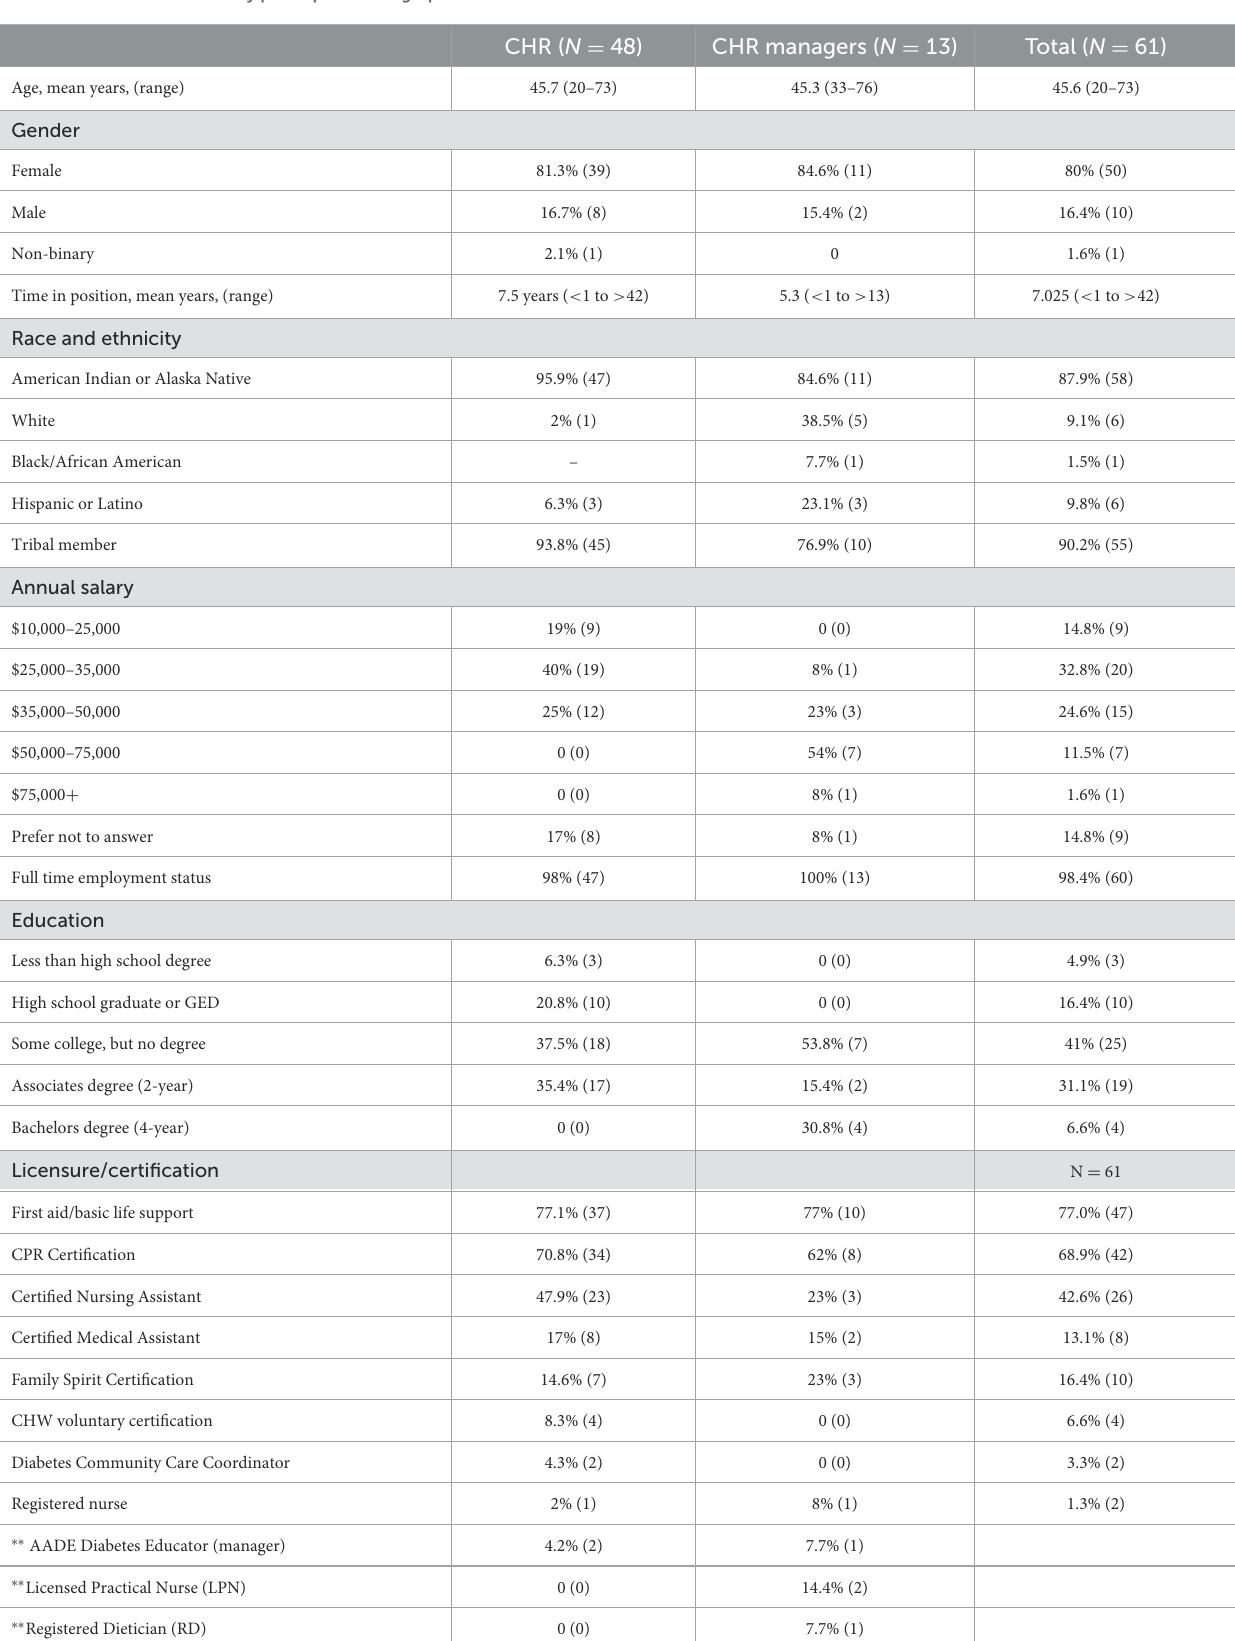
TABLE 1 CHR workforce survey participant